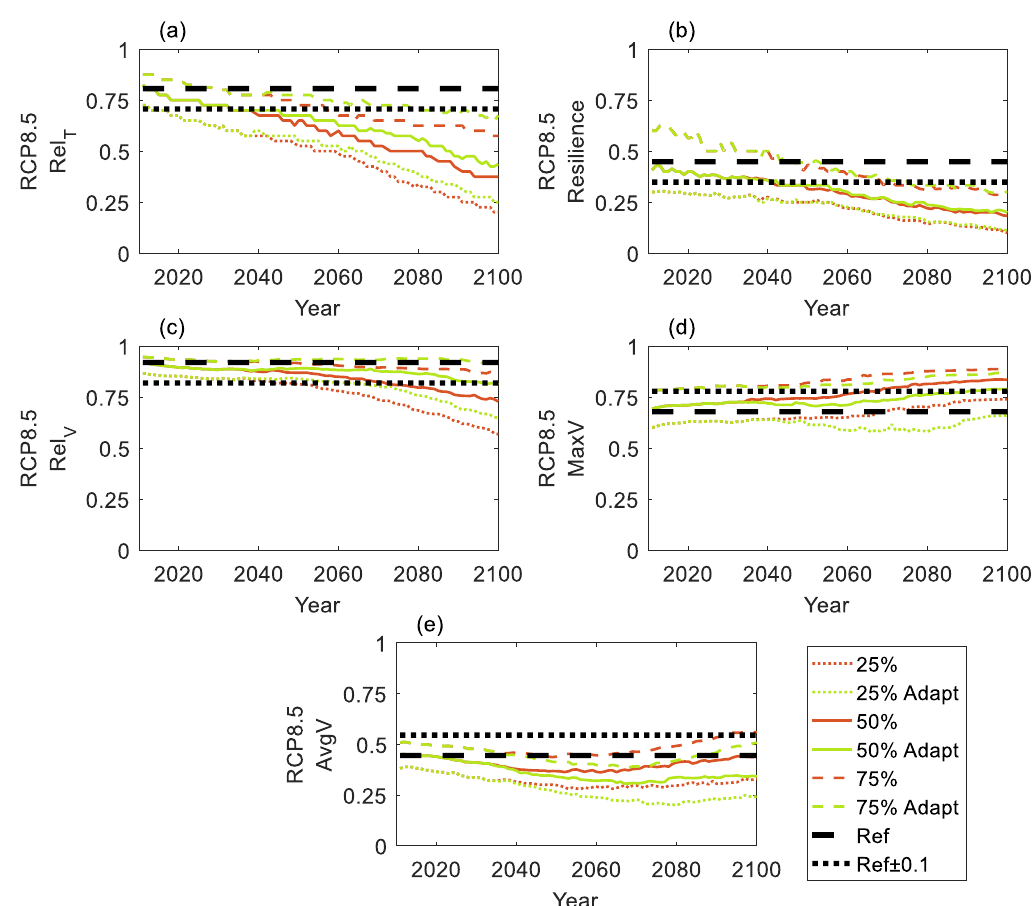
Figure 11. Performance indexes obtained using the current operation rule (red) and a reduced allocation goal implemented the ToE year (2033) as an adaptation strategy (green). The adaptation (current) allocation goal is 205 (240), 35 (40), and 35 (40) Mm 3 , for the Paloma, Cogotí, and Recoleta reservoirs, respectively. Indexes include the time-based reliability ( a ), resilience ( b ), volume-based reliability ( c ), maximum vulnerability ( d ) and average vulnerability ( e ), for a 40-year moving window, with the horizontal axis being the last year of the window. The thick dashed and dotted lines represent the reference historical performance and 10% worse-than-the-reference value, respectively.